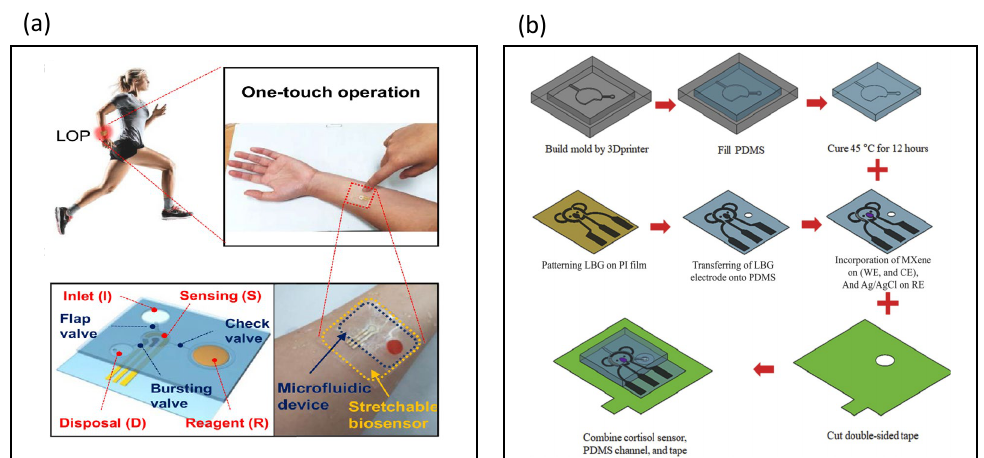
Figure 10. Stretchable impedance biosensors. ( a ) All-polymer electrochemical microfluidic biosensors were used for sensing the biomarker cortisol in sweat. The pullable body impedance biosensor was designed at the bottom layer and attached to the skin. Reproduced with permission from [147].